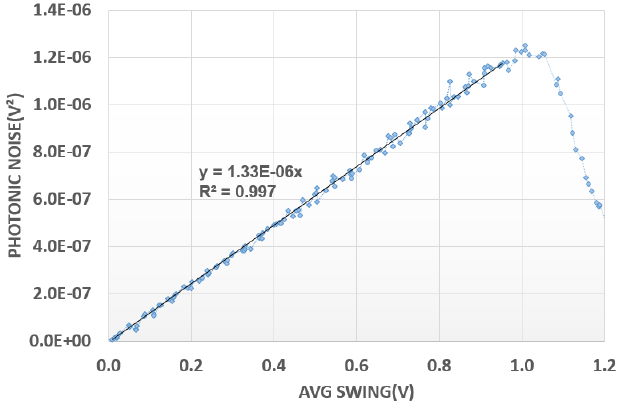
Figure 7. Hole photonic noise.